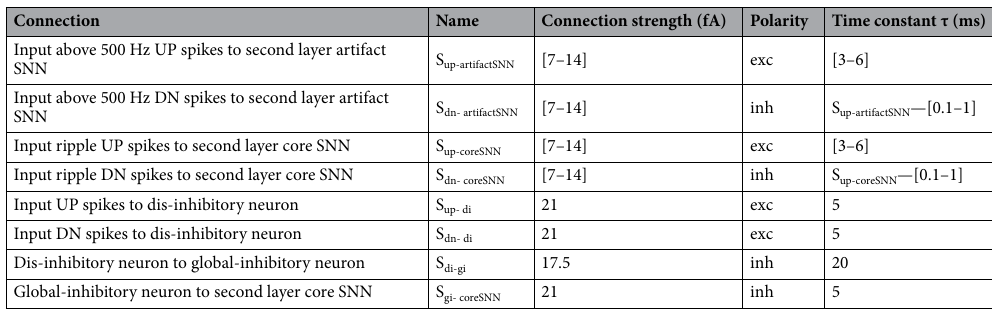
Table 1. EEG SNN parameters. Synapse parameters of the EEG SNN detector. A connection between two neurons is characterized by the positive (excitatory, exc) or negative (inhibitory, inh) current in fA and the time